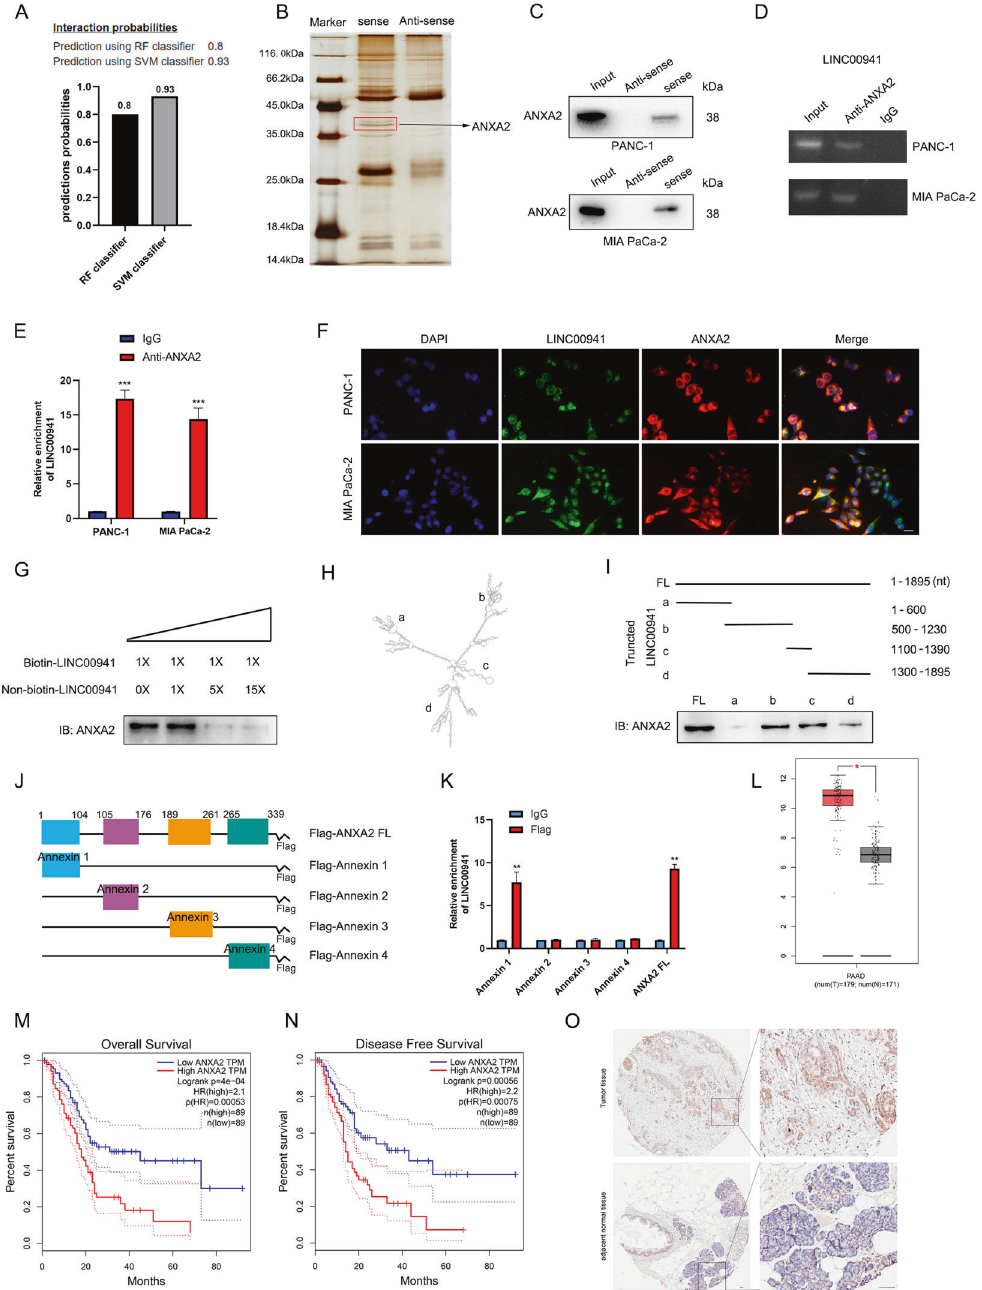
Fig. 2 LINC00941 can interact with ANXA2 protein. A Bioinformatic prediction (RNA – Protein Interaction Prediction, RPISeq) was performed to predict the probability of the interaction between LINC00941 and ANXA2 by analyzing their sequences. Interaction probabilities generated by RPISeq range from 0 to 1. In performance evaluation experiments, predictions with probabilities >0.5 were considered “ positive ” . B Silver- stained SDS-PAGE gel of proteins immunoprecipitated by the sense and antisense of LINC00941. The differentially exhibited lanes were used for the mass spectrum. Among them, ANXA2 was one of the potential binding protein. C Immunoblotting for speci fi c correlation of ANXA2 with LINC00941 from RNA pull-down assays. D RNA-binding protein immunoprecipitation (RIP) assay was further used to validate the interaction between ANXA2 and LINC00941, followed by agarose gel electrophoresis. E RIP assay for ANXA2 followed by qRT-PCR analysis. F Immuno fl uorescence was performed to clarify the co-location of LINC00941 and ANXA2. G Competitive RNA pull-down assays for LINC00941 followed by immunoblotting analysis. H The secondary structure of LINC00941 was simulated via importing the sequence of LINC00941 into ViennaRNA. I According to the secondary structure of LINC00941, the relevant full-length and truncated LINC00941 were constructed. RNA-pull-down assay for full-length and truncated LIN00941 followed by immunoblotting analysis. J The schematic diagram of full-length and truncated ANXA2. K RIP assay for full-length and truncated ANXA2 followed by qRT-PCR analysis. L The expression of ANXA2 in pancreatic cancer tissues compared to normal tissues based on the TCGA database. M , N Kaplan – Meier curve respectively evaluated the overall survival and disease-free survival of 178 pancreatic cancer patients based on the TCGA database. O The expression of ANXA2 in pancreatic cancer tissues and adjacent normal tissues by IHC analysis. *, **, and ***, respectively, represent P < 0.05, P < 0.01, and P < 0.001.